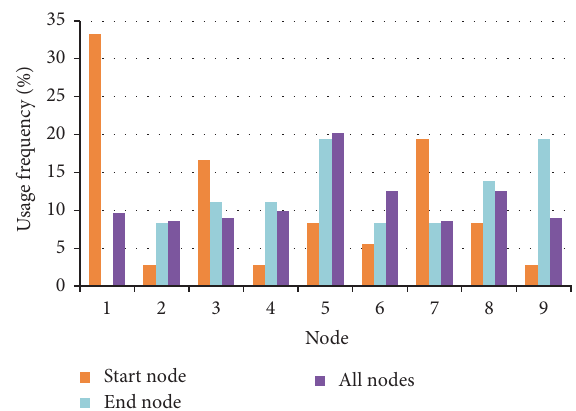
Figure 6: The usage frequency of nodes in participants’ selected patterns for the enhanced lock